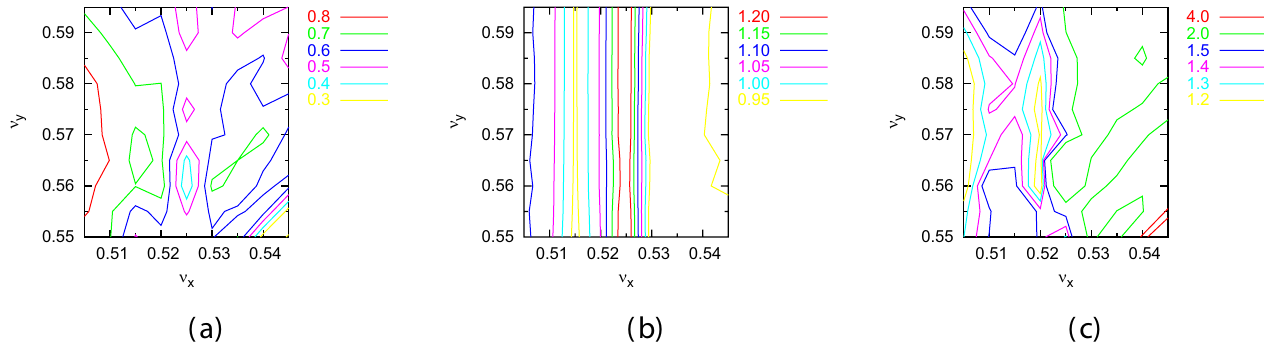
FIG. 7. (Color) Luminosity and beam size (rms) versus transverse tune at design parameters. The luminosity, which is depicted in (a), is normalized by the design value. The horizontal and vertical beam sizes, which are normalized by the corresponding nominal values, are depicted in (b) and (c), respectively.